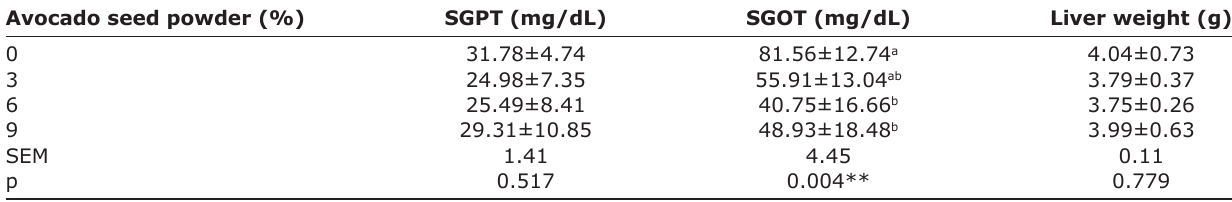
Table-2: The average level of SGPT and SGOT of culled female quail. Avocado seed powder (%) SGPT